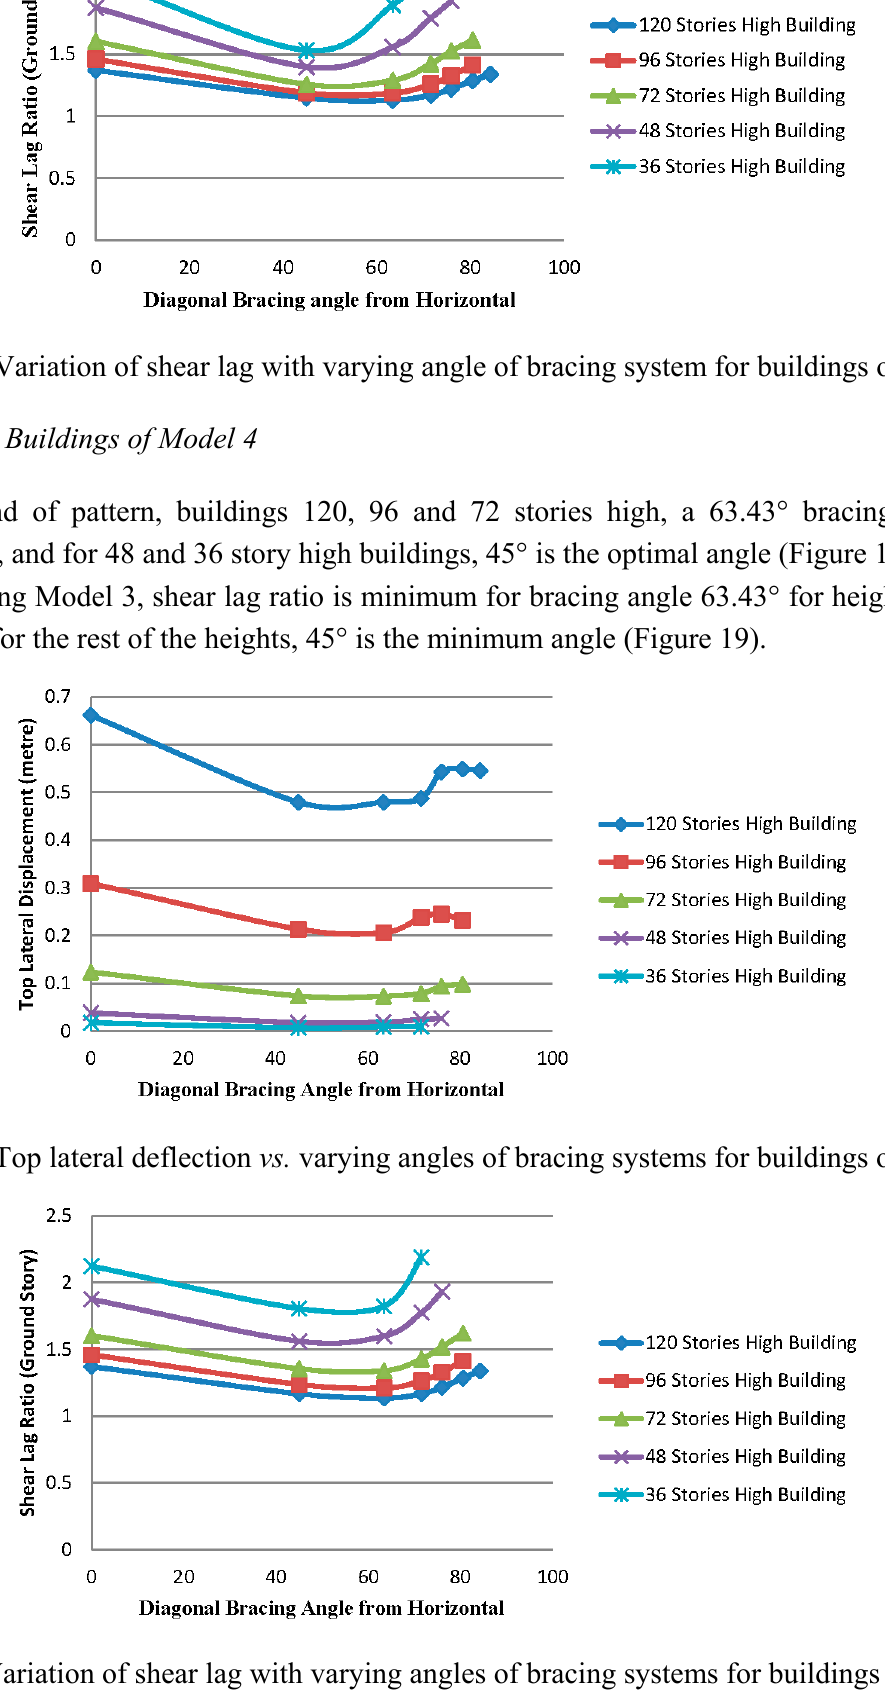
Figure 19. Variation of shear lag with varying angles of bracing systems for buildings of Model